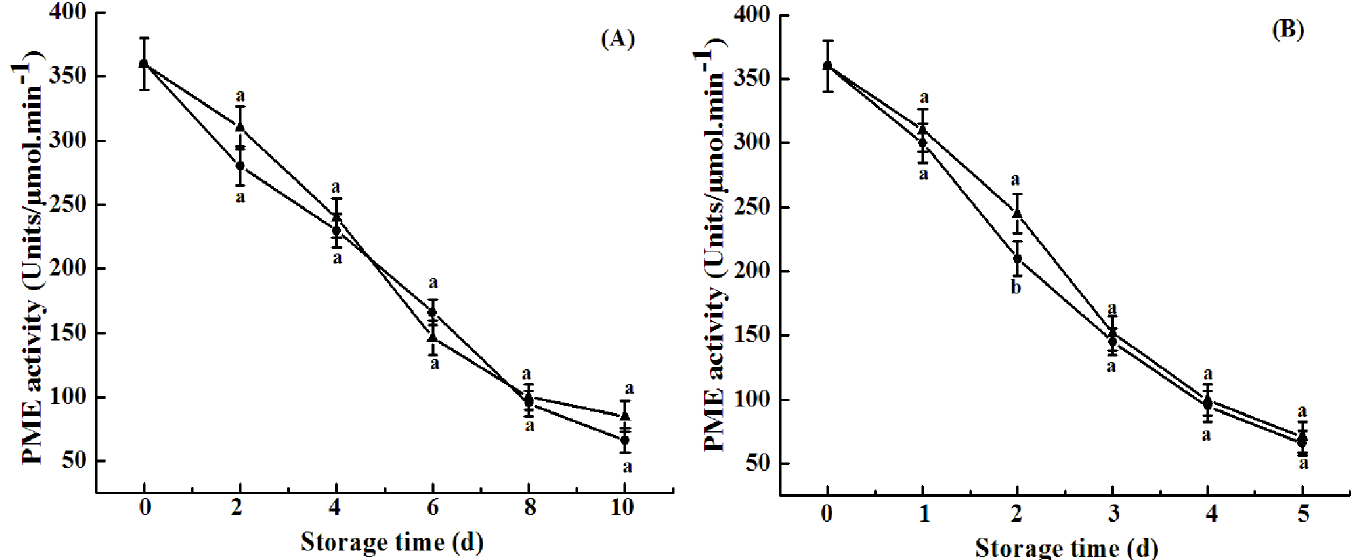
Fig 6. PME activity of avocado fruits upon natural (A) or ethylene-induced (B) ripening with ( ● ) or without ( ▲ ) cold shock treatment (CST) during 10- or 5-day storage at 20˚C and 85–90%RH. Vertical bars represent the standard error of three replicates.Different letters at any storage time indicate significantdifferences (P < 0.05).